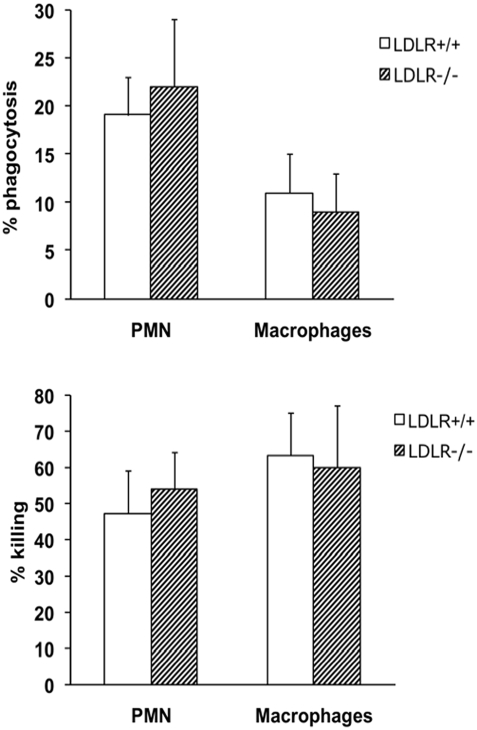
Phagocytosis and killing of S. typhimurium by neutrophils and macrophages of LDLR−/− mice.Phagocytosis of S. typhimurium after 15 min incubation, and intracellular killing of S. typhimurium after 4 h, by proteose peptone-elicited peritoneal neutrophils and macrophages. Data are expressed as percentage of the initial number of microorganisms. No significant differences between LDLR−/− and LDLR+/+ were found.